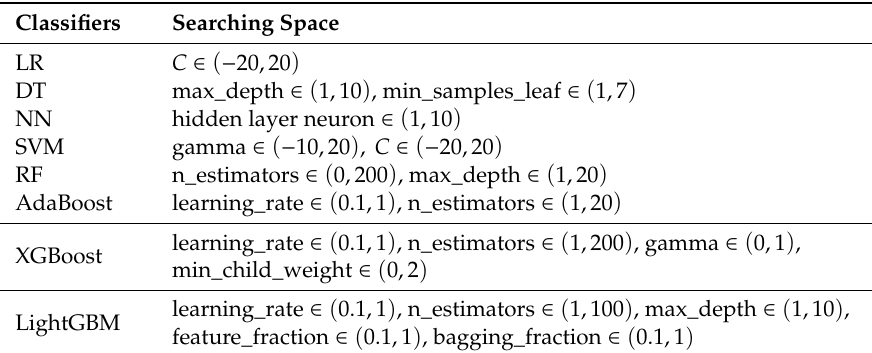
Table 1. Search space of parameter